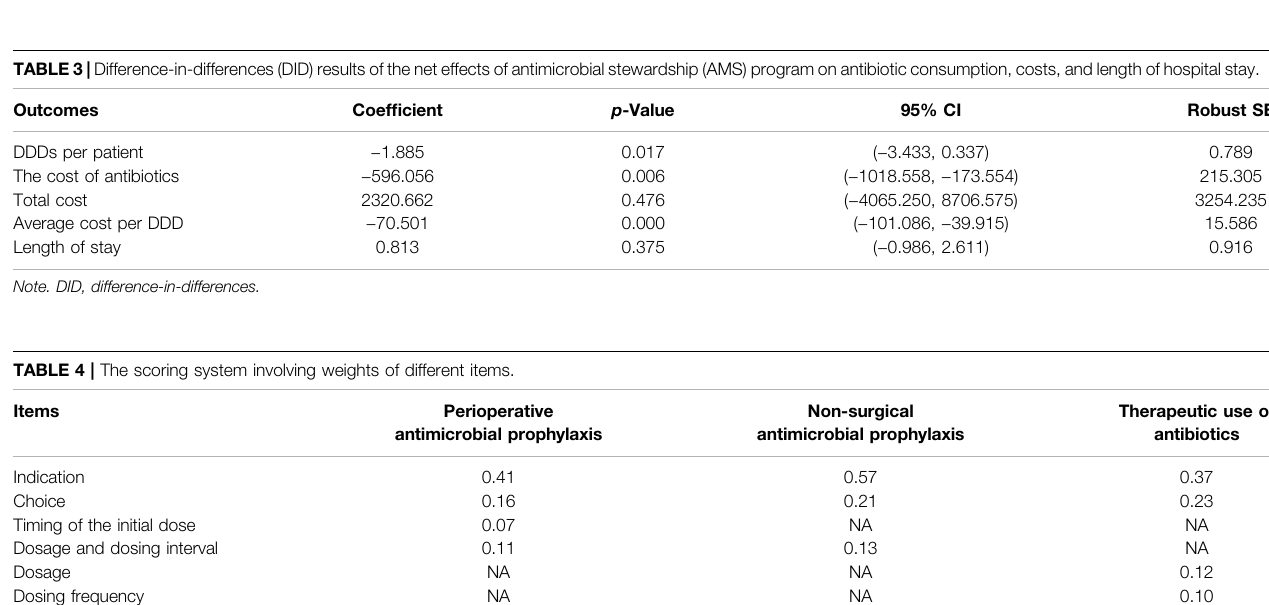
antimicrobial prophylaxis